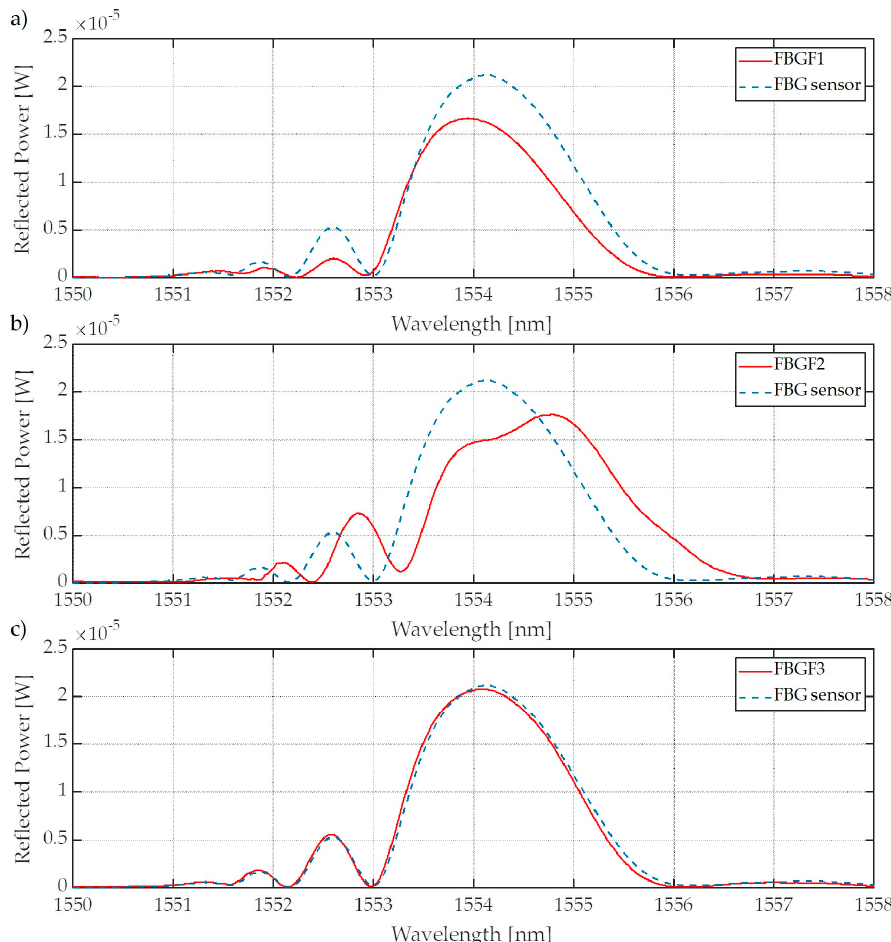
Figure 6. The spectral characteristics of gratings used in measurements: ( a ) filter Bragg grating (FBG) filter with a center wavelength shorter than the sensor, ( b ) FBG filter with a center wavelength longer than the sensor, ( c ) FBG filter with a center wavelength equal to the sensor.